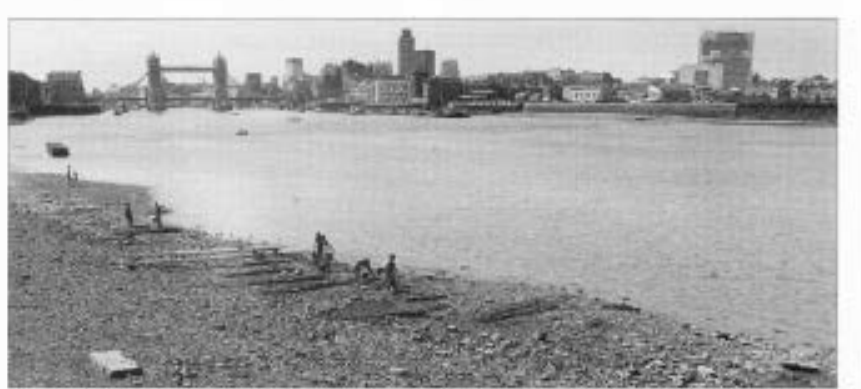
Figure 2 The head of a figurine made of unbaked clay from the site of Huaca de la Luna in the Moche Valley, northern Peru, dated to the first millennium AD; height